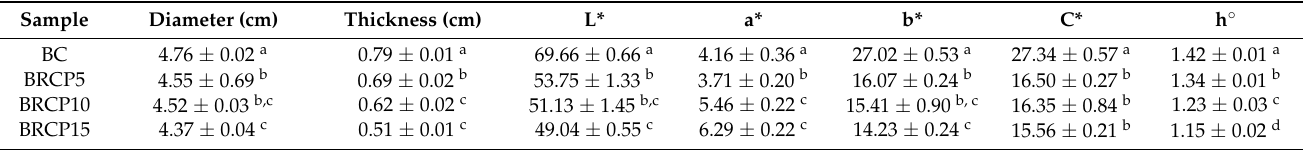
Table 2. Physical parameters and color of